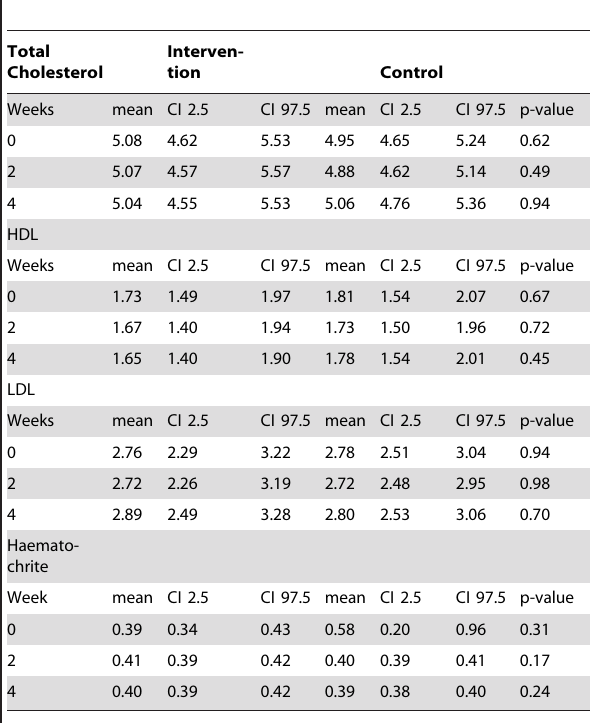
Table 4. Mean, confidence intervals and p-values for selected blood samples, p-values calculated using Students test.